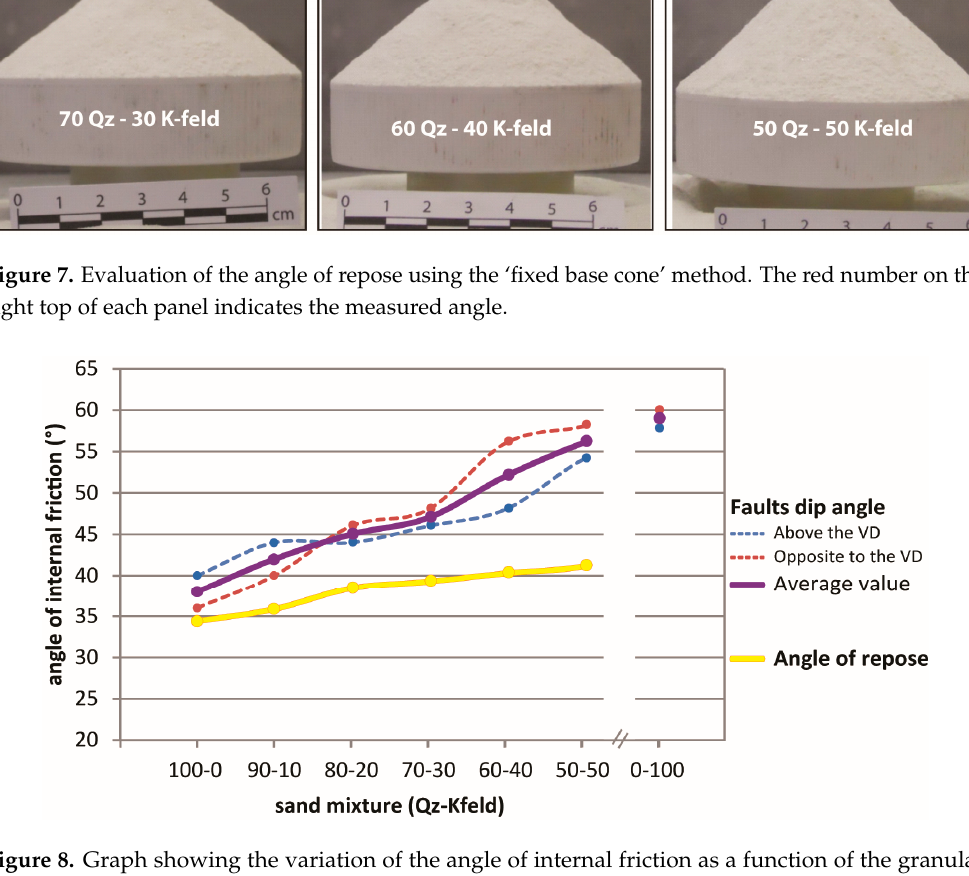
Figure 8. Graph showing the variation of the angle of internal friction as a function of the granular mixture composition as measured with the adopted empirical methods.